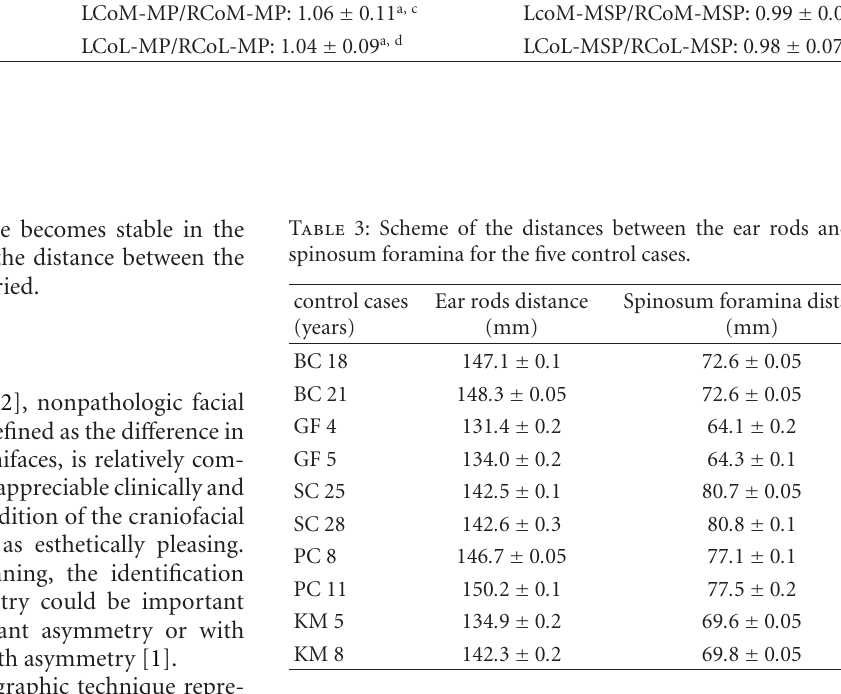
Table 2: Statistical analysis comparing the di ff erences in the symmetry ratio using Tracing 1 and Tracing 2. Left/right symmetry ratio (SR)